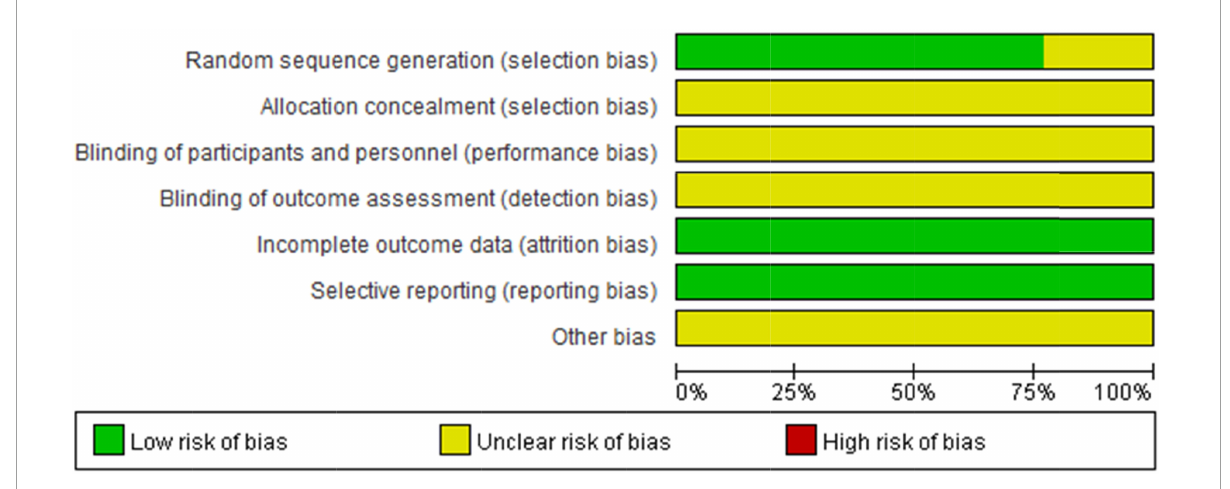
FIGURE3 Risk of bias graph: review authors’ judgments about each risk of bias item presented as percentages across all included studies.